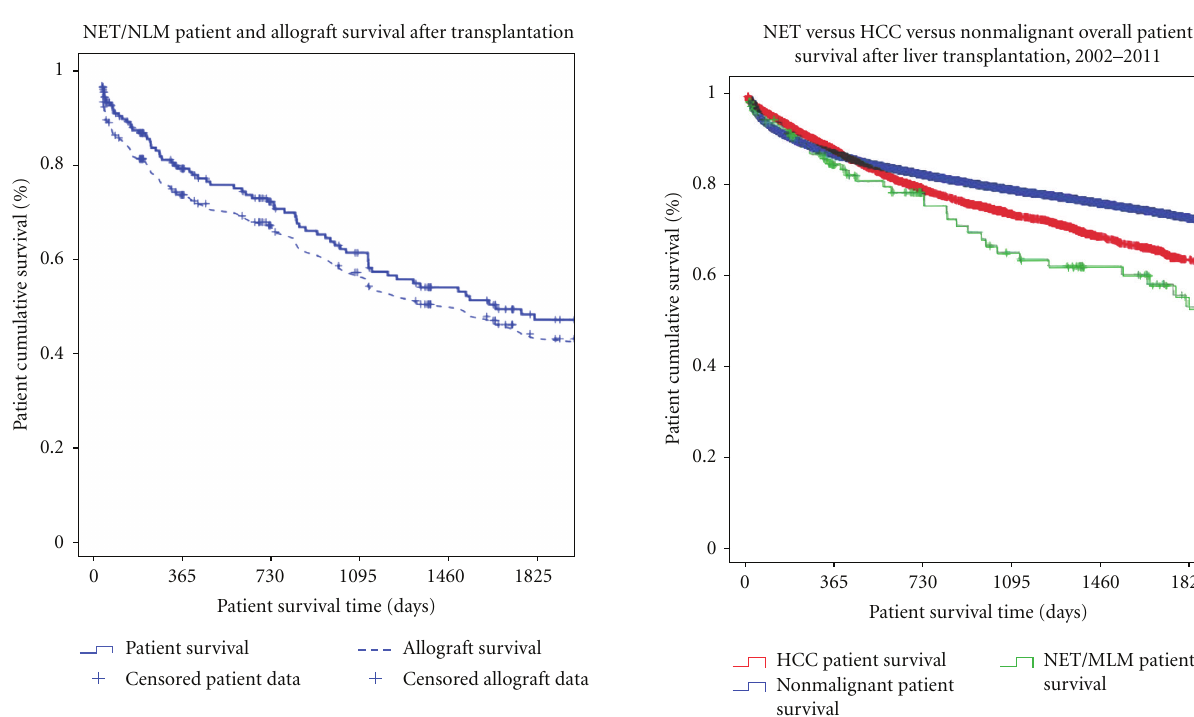
Figure 3: Neuroendocrine liver metastases: patient and allograft survival after transplantation, 1988–2011.